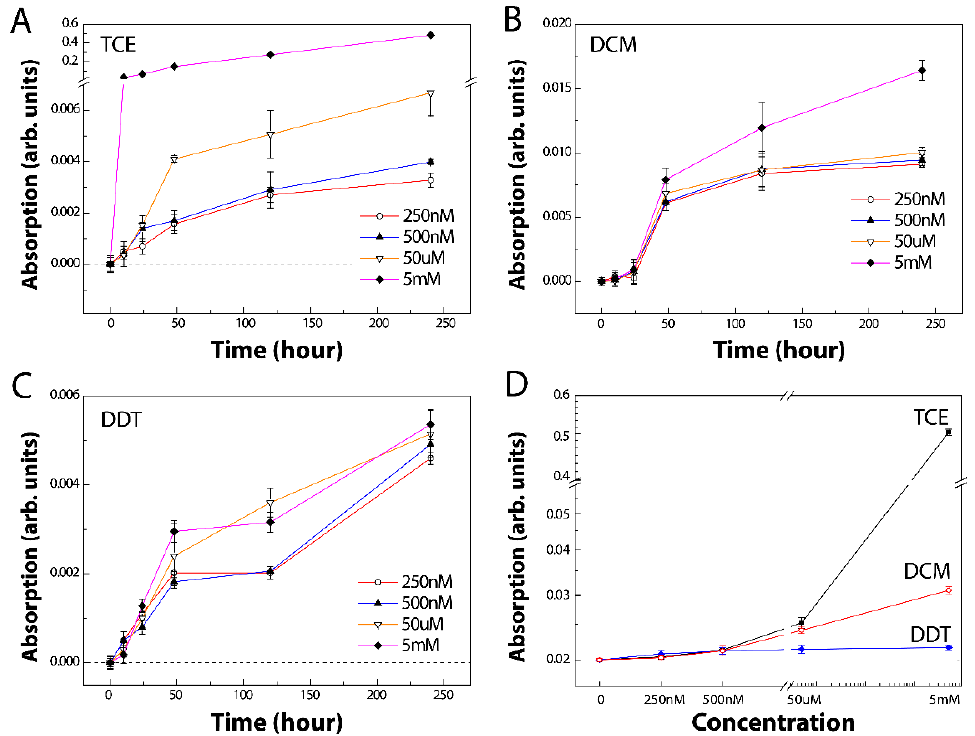
Figure 3. Limit of detection of three organochlorides measured at a wavelength of 450 nm in the presence of DBN. ( A ) TCE, ( B ) DCM, ( C ) DDT. Absorption was recorded for 240 h. ( D ) Absorption with various TCE, DCM, and DDT concentrations.